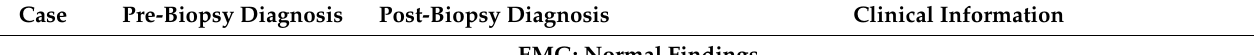
Table 5. A list of patients undergone muscle biopsy whose EMG did not show myopathic change. Case Pre-Biopsy Diagnosis Post-Biopsy Diagnosis Clinical Information EMG: Normal